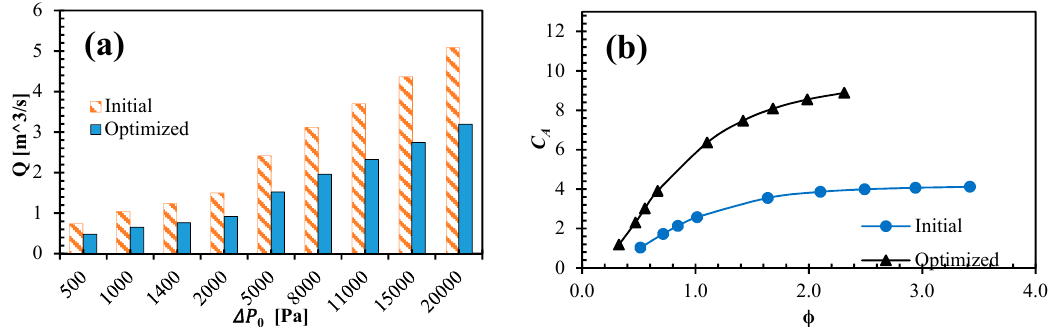
Figure 12. Comparison of flow rate ( a ) and the input coefficient ( b ) of the optimised design with the initial outflow turbine geometry. (( a ) Horizontal axis: total-static pressure drop, ( b ) Horizontal axis: flow coefficient).